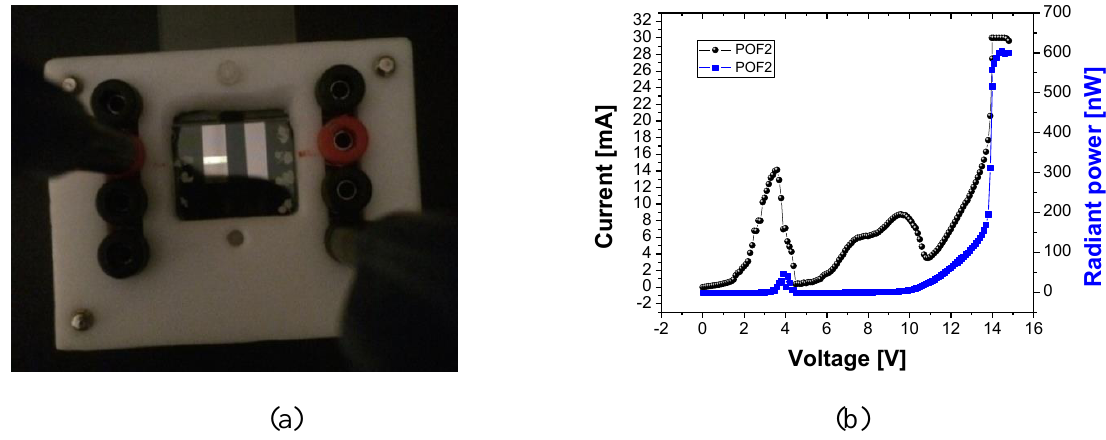
Figure 9. The image of the OLED device ( a ) and current–luminance–voltage curve for ITO/PEDOT:PSS/POF/Al device ( b ).